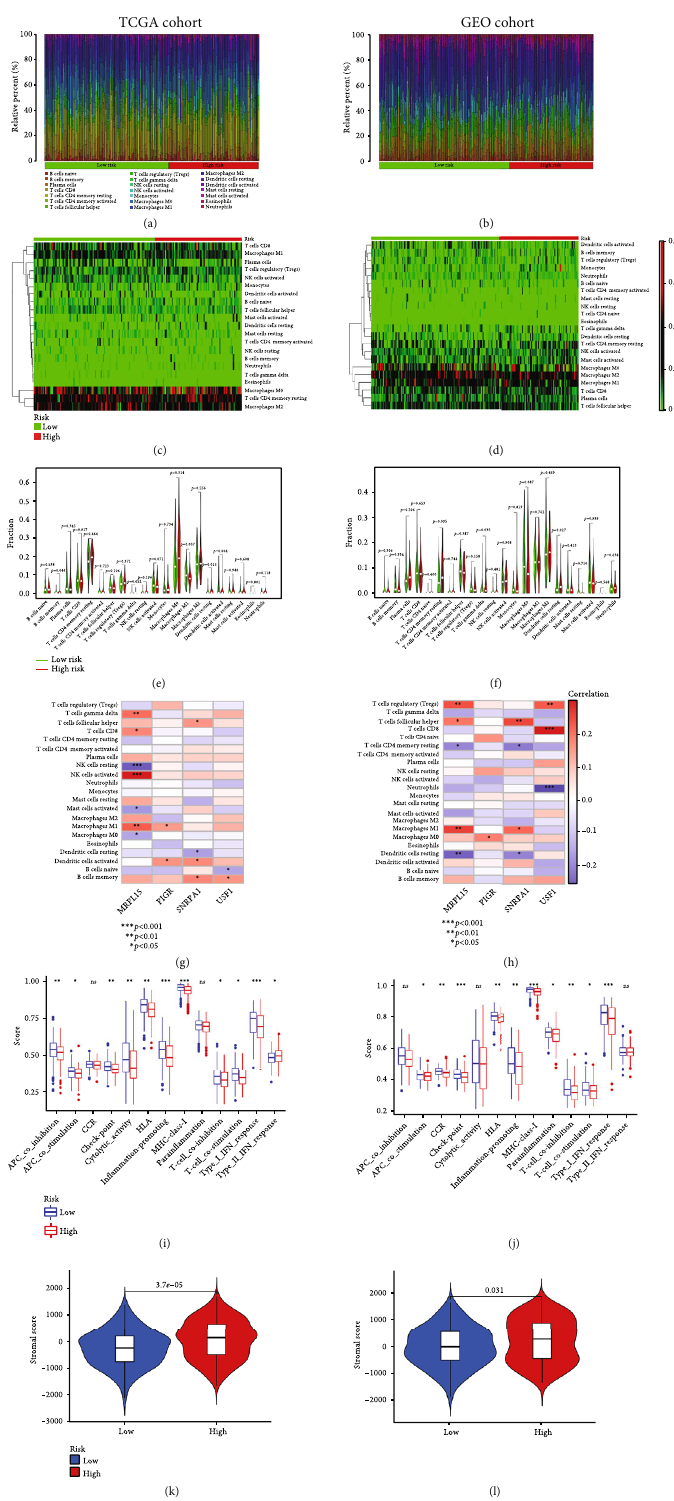
Figure 5: Analysis of the connection between tumor microenvironment and risk score in TCGA and GEO cohorts. (a, b) The relative proportion of immune-in fi ltrating cells in di ff erent risk groups. (c, d) Expression of each immune-in fi ltrating cell in di ff erent risk groups. (e, f) Comparison of immune-in fi ltrating cells in low-risk and high-risk groups. (g, h) Correlation between four important prognostic genes and immune-in fi ltrating cells. (i, j) Comparison of ssGSEA scores for 13 immune-related functions between high-risk and low-risk groups. Adjusted p values are shown as ns: not signi fi cant; ∗ p < 0 : 05 ; ∗∗ p < 0 : 01 ; ∗∗∗ p < 0 : 001 . (k, l) Comparison of stromal scores between di ff erent risk